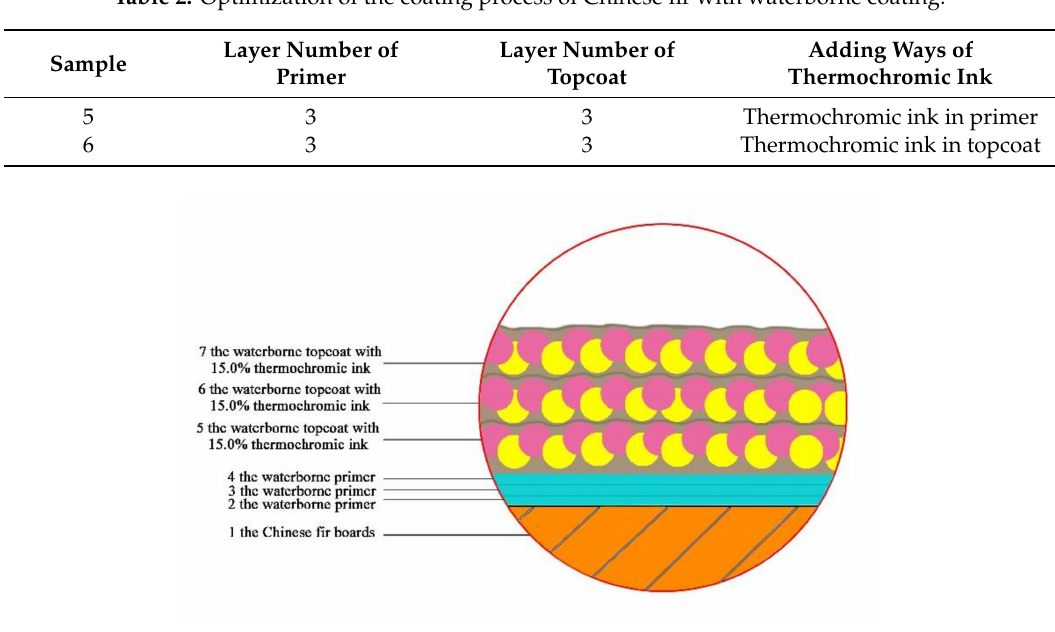
Table 2. Optimization of the coating process of Chinese fir with waterborne coating.